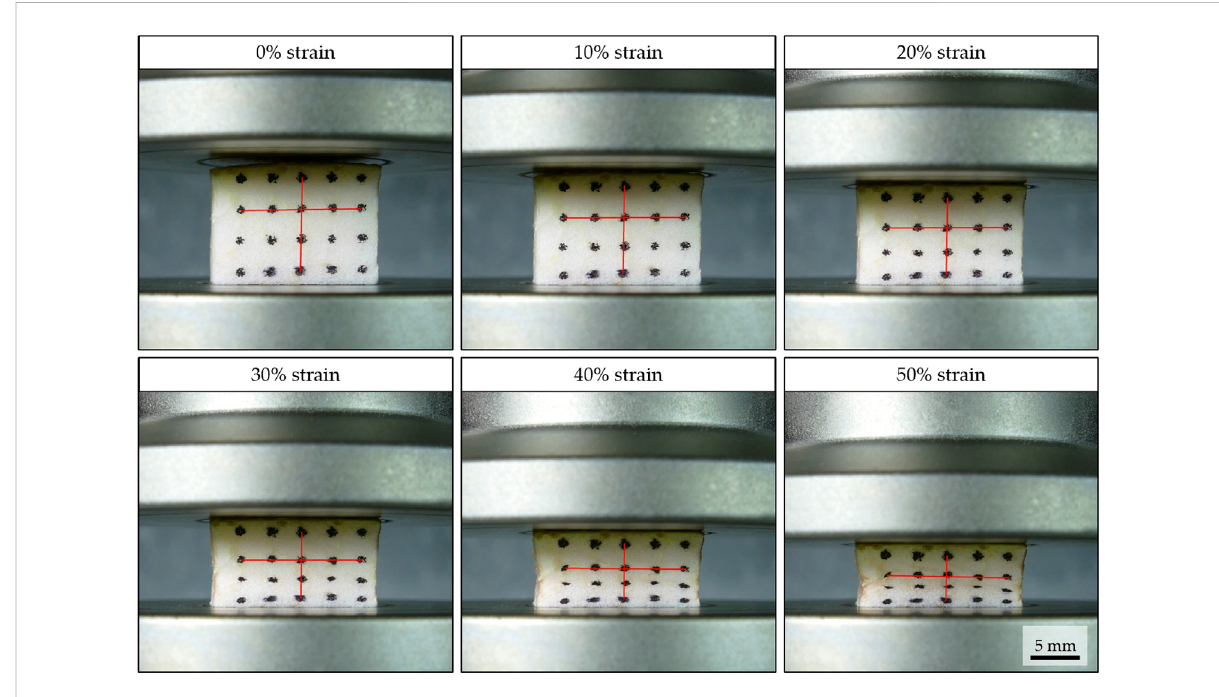
FIGURE 5 Characteristicdeformationimagesofthepeelofpomelo( C.maxima )atincreasingstrain.Sampleheightatastrainlevelof0%equals12.38